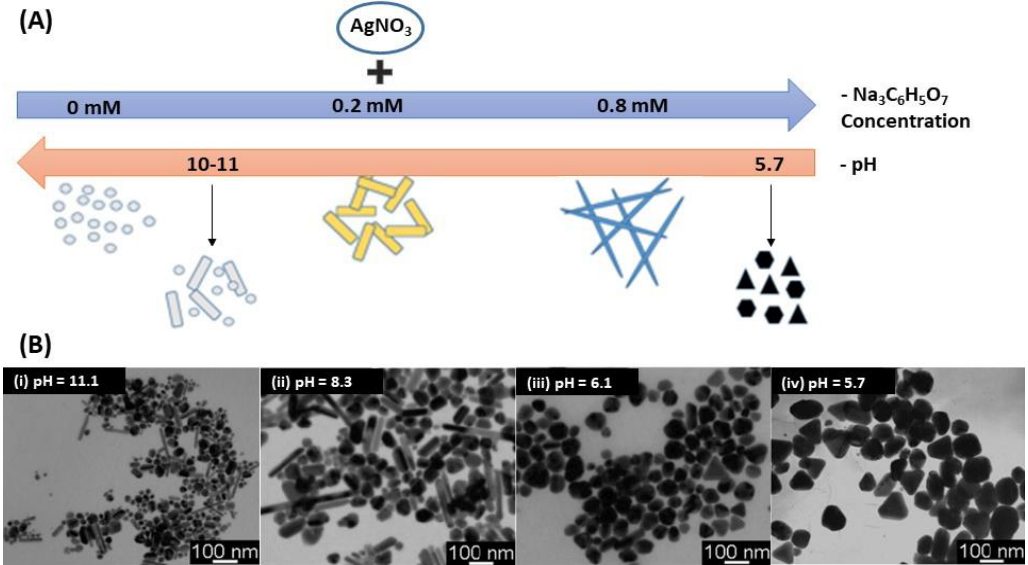
Figure 1. AgNPs synthesis using citrate: ( A ) Experimental conditions affecting the silver nanoparticle AgNPs shape and ( B ) TEM images of the AgNPs synthesized at different pH values: (i) 11.1, (ii) 8.3, (iii) 6.1 and (iv) 5.7. Adapted from [72]. Copyright (2009), American Chemical Society.